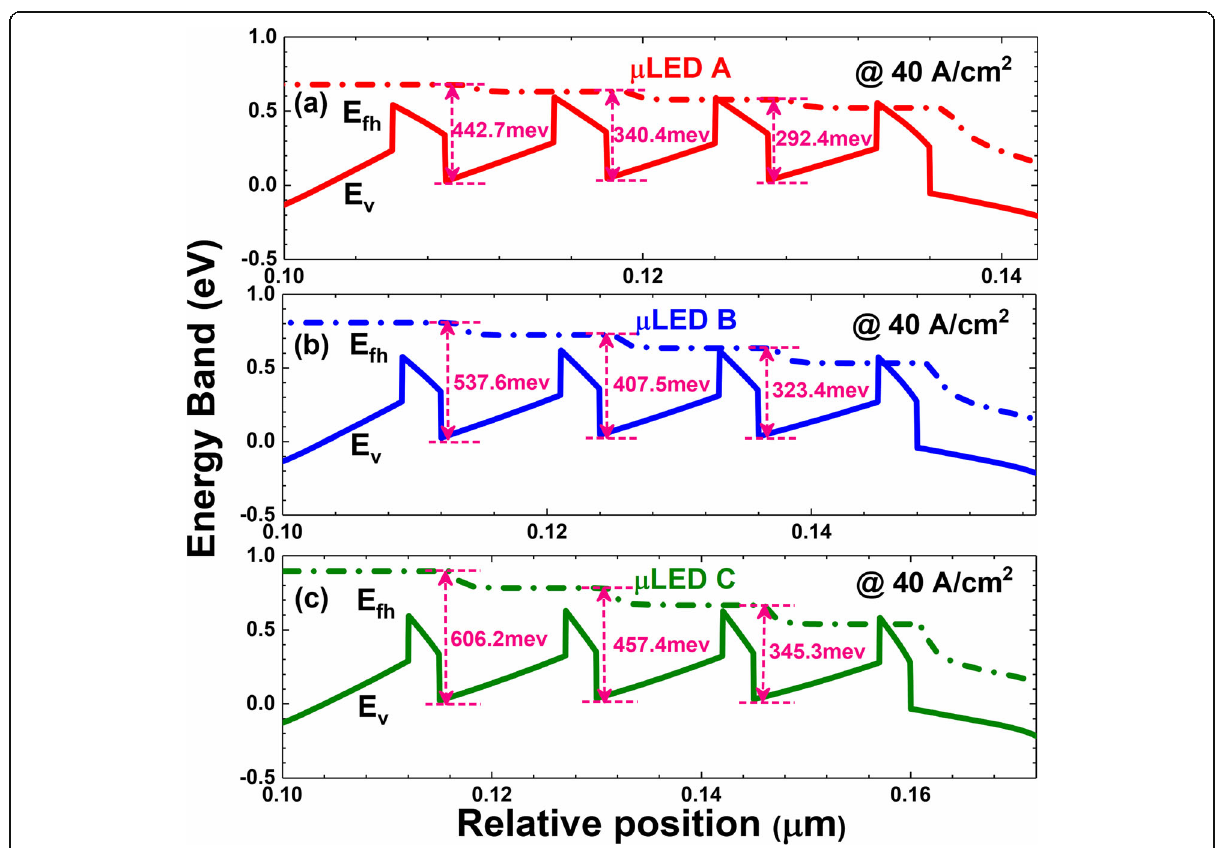
Fig. 4 Energy band diagrams for μ LEDs ( a ) A, ( b ) B, and ( c ) C. E v , and E fh denote the valance band and quasi-Fermi level for holes, respectively. The data care calculated at the current density of 40 A/cm